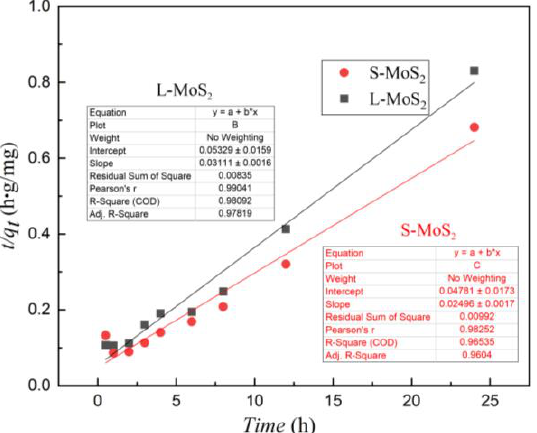
Figure 8. Pseudo-second-order kinetic models for S-MoS 2 and L-MoS 2 adsorption of Cu 2+ (The in- serted chart: the parameter of the linear fitting).